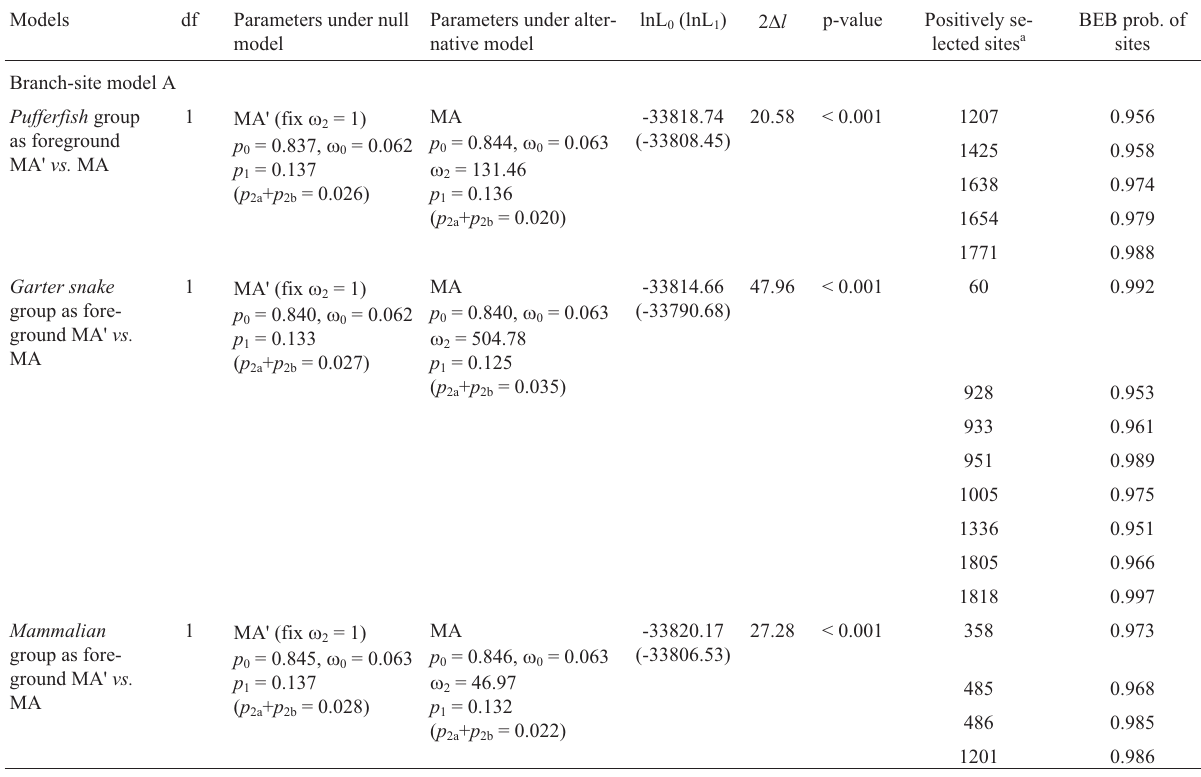
Models Parameters under null